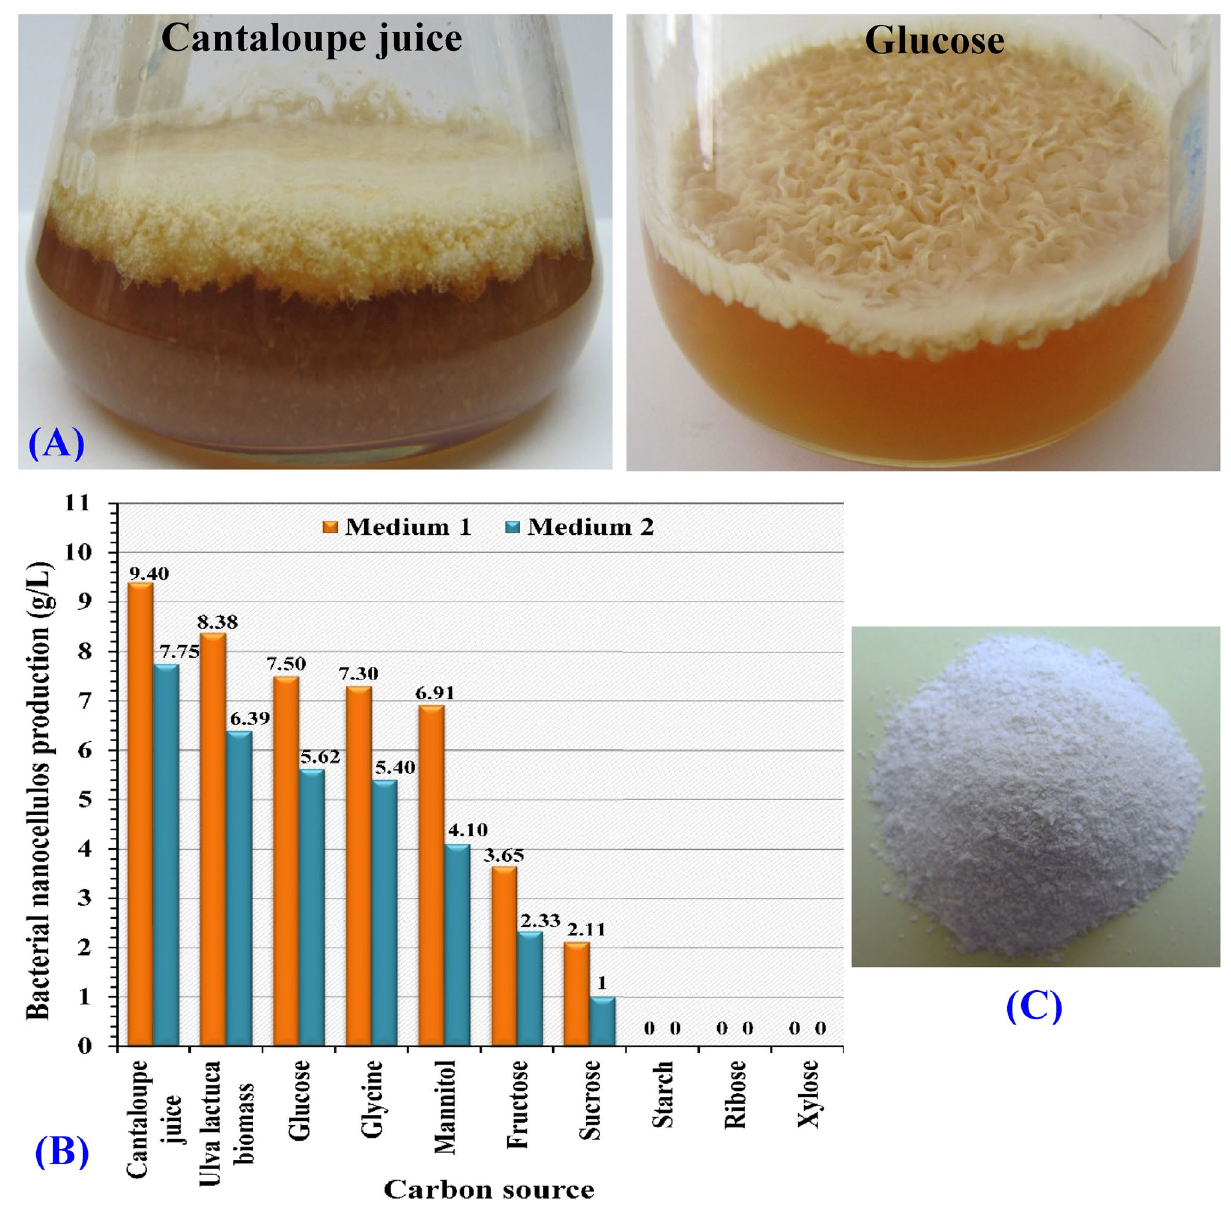
Figure 1. ( A ) Bacterial cellulose layer produced at the air–liquid interphase. ( B ) Purified powder of the bacterial nanocellulose. ( C ) Effect of ten carbon sources on bacterial cellulose production after 14 days of static cultivation on different carbon sources at 37